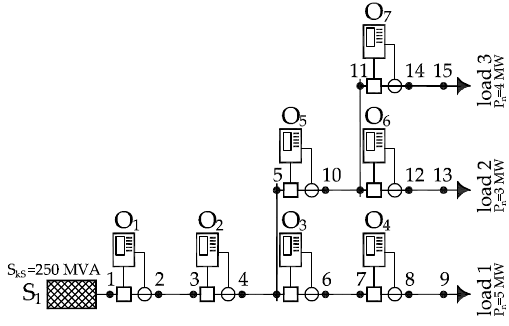
Figure 9. Coordinated IEEE 6-bus power system.